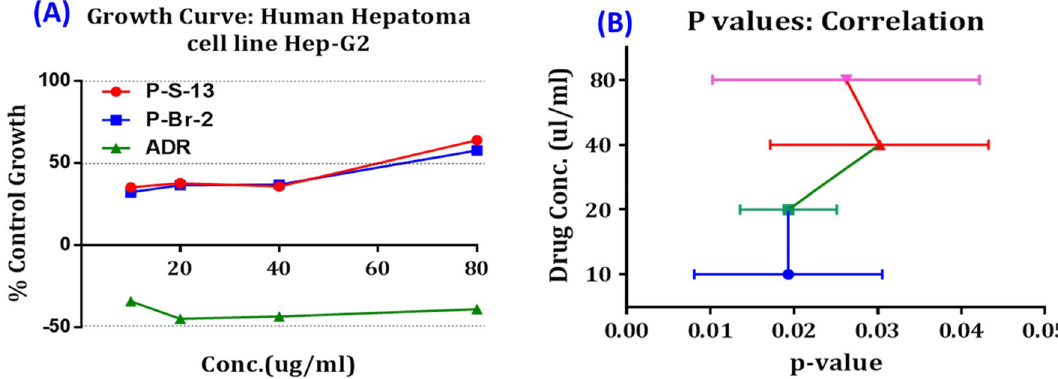
Figure 4. ( a ) Growth curve of Human Hepatoma Cell Line treated with mulberry pectin: BR-2, S-13 and Adriamycin (positive control drug); ( b ) Significant correlation of p-value with different doses of pectin.